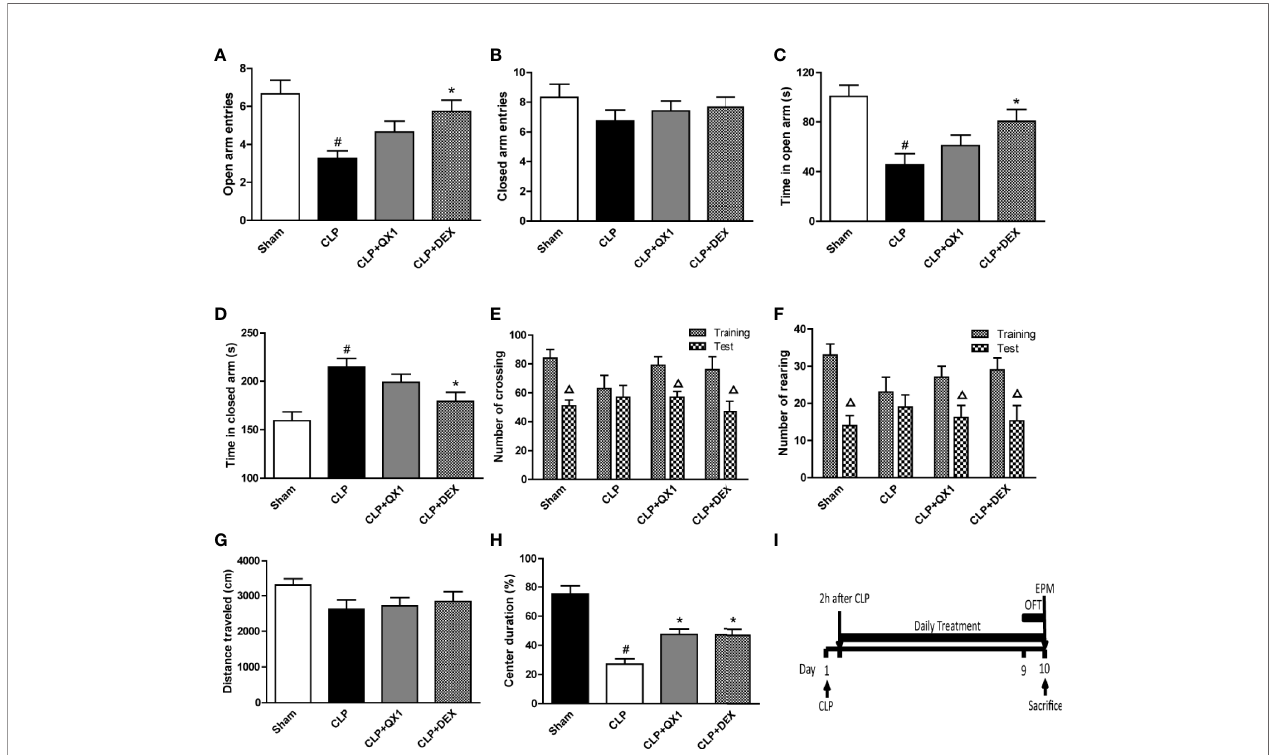
FIGURE 4 | QX1 formula ameliorates emotional dysfunction in septic mice. Mice were randomized divided into sham, CLP, CLP treated with QX1 formula, and CLP treated with DEX groups. Mice were treated with QX1 formula (2 g/kg) or DEX (1 mg/kg) beginning at 2 h after CLP surgery. DEX was used as a positive control. In the elevated plus maze, (A) open arm entries, (B) closed arm entries, (C) time spent in the open arms, and (D) time spent in the closed arms were evaluated respectively. In the open fi eld task, (E) the number of crossings and (F) rearings, (G) total distance traveled, and (H) percentage of center duration in the 5 min test were presented respectively. (I) the fl ow chart of open fi eld task and elevated plus maze test. Data were shown as mean ± SD (n=8-12 per group). # p < 0.05 vs. sham, * p < 0.05 vs. CLP, △ p < 0.05 vs. training, one-way ANOVA. CLP, Cecal Ligation and Puncture; QX1, Qiang Xin 1; DEX,